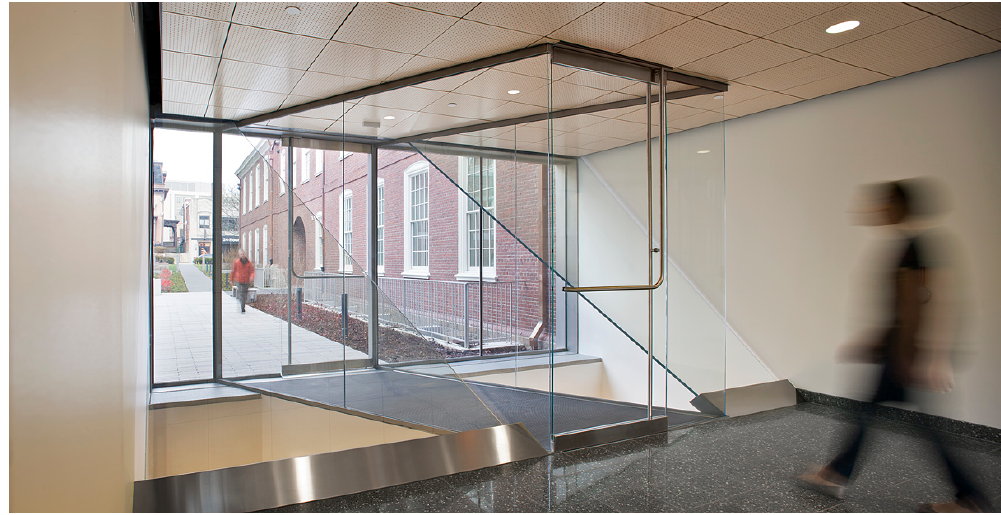
Fig. 4 P-131317, 2011 | Glass and existing architecture | Total dimensions variable Brown University Cognitive Science Building | Providence RI, USA Photo Credit: Warren Jagger | Interior daytime view